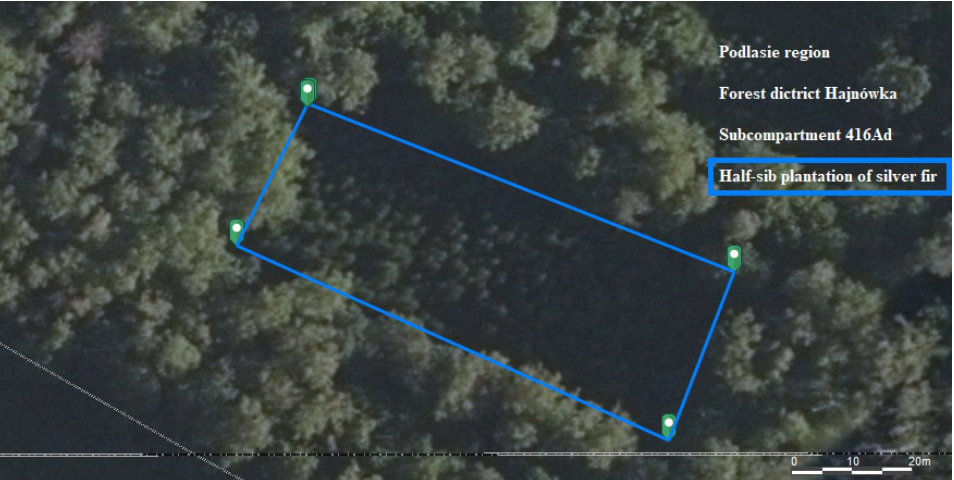
Figure 1. Location of the area according to Forest Data Bank (https://www.bdl.lasy.gov.pl/portal/ accessed on 5 January